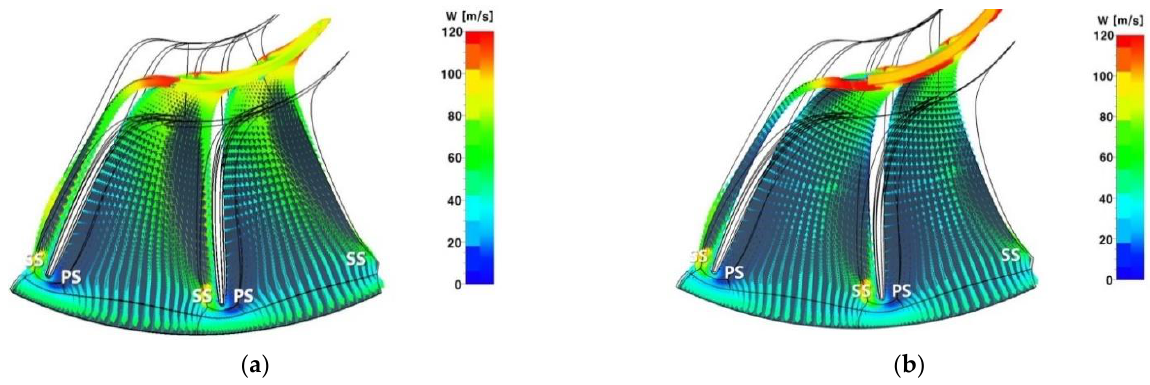
Figure 17. Comparison of relative velocity distribution at Plane 1: ( a ) original model and ( b ) opti- mized model.